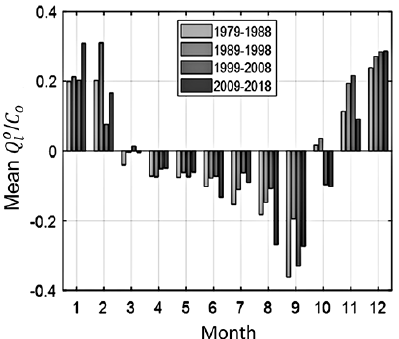
Figure 12. Monthly wave factor of the longshore sediment trans- port ( Q l /C ol ) using NOAA wave data.